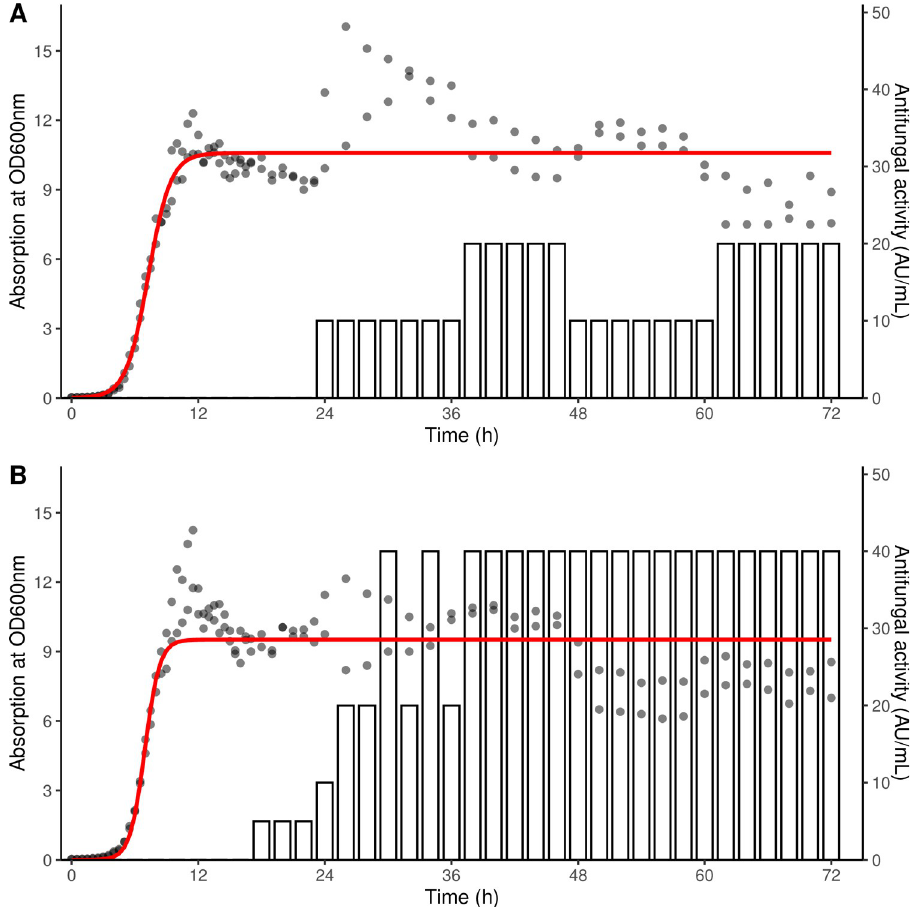
Fig 6. Growth curve and antifungal activity curve for Bacillus velezensis WRB-ZX-001 (A) and WRB-ZX-002 (B). Growth curve was plotted by measuring absorption at OD 600nm every 30 min and a standard form of logistic equation was used to fit the absorption data (red line). Antifungal activity was measured by well diffusion overlay inhibition assay of serially diluted cell-free supernatant every two hours against fungal indicator strain Aspergillus fumigatus and data were shown in bar plots.